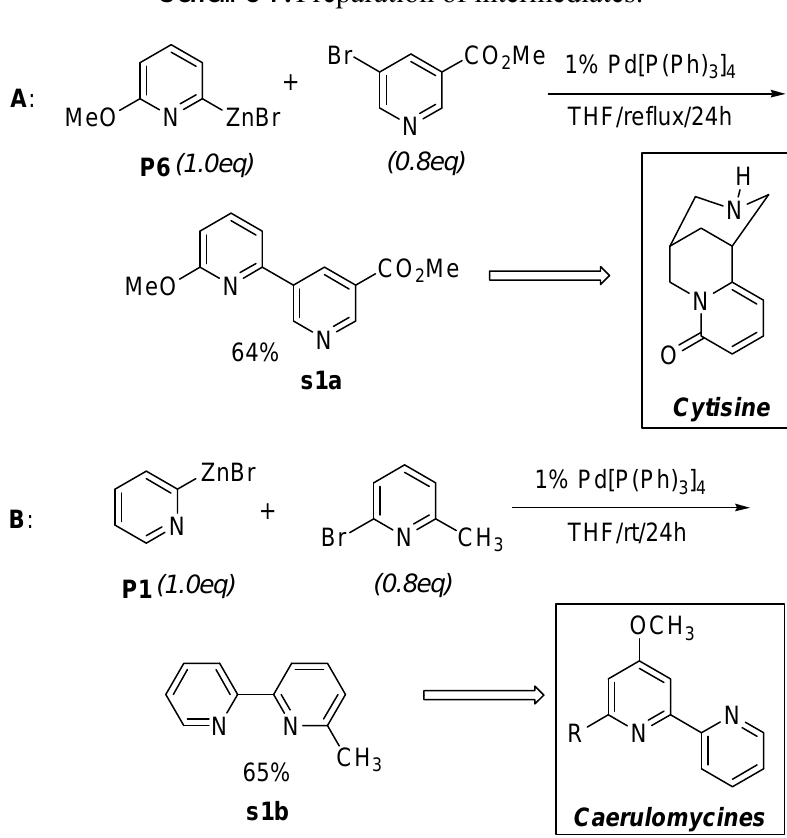
Scheme 1. Preparation of